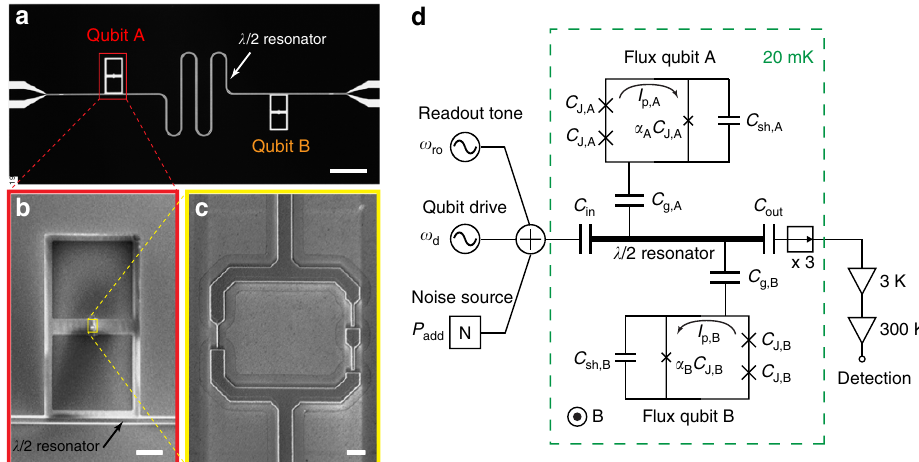
Figure 1 | C-shunt flux qubit. ( a ) Optical micrograph of the 2.5 (cid:4) 5.0mm 2 chip, aluminium (black) on sapphire substrate (white, where the aluminium has been etched away), featuring two qubits (A and B) and a l /2 coplanar waveguide resonator ( o r /2 p ¼ 8.27GHz). Scale bar, 0.5mm. ( b ) SEM image of the shunt capacitor ( C sh,A ¼ 51fF) for qubit A. Each square plate of the capacitor is 200 (cid:4) 200 m m 2 . The lower plate capacitively couples the qubit to the l /2 resonator. Scale bar, 50 m m. ( c ) Magnified view of the shadow-evaporated qubit loop and its three Josephson junctions. The left junction area is smaller by a factor a A ¼ 0.42. Scale bar, 1 m m. ( d ) Device and measurement schematic. Experiments are performed in a dilution refrigerator at 20mK. A global magnetic field B provides a magnetic flux bias F b to each qubit. A qubit drive tone ( o d ), readout tone ( o ro ) and externally generated noise ( P add , see Figs 5 and 6) enter the l /2 resonator defined by capacitances C in and C out . The resonator is capacitively coupled ( C g,A/B ) to qubits A and B. The qubit junctions (‘x’) have internal capacitance, C J,A/B and a A/B C J,A/B , and are externally shunted by capacitance C sh,A/B . Each qubit loop supports a circulating persistent current I p,A/B . Readout signals at the resonator output pass three isolators (‘ - ’), are amplified at cryogenic and room temperatures, and subsequently detected. See supplementary online material for more